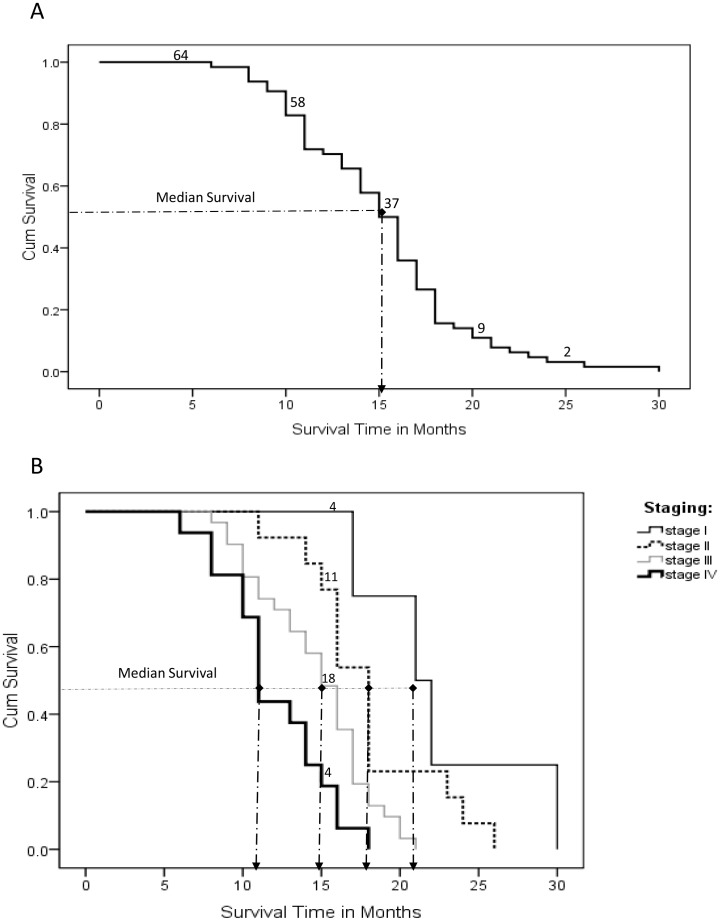
Kaplan Meir Survival Curves.(A). Overall median survival of 15.0 months; (B) Stratified median survival based on FIGO staging, whereby, stage I was 21 months with stages II, III, and IV having 18, 15 and 11 months respectively.